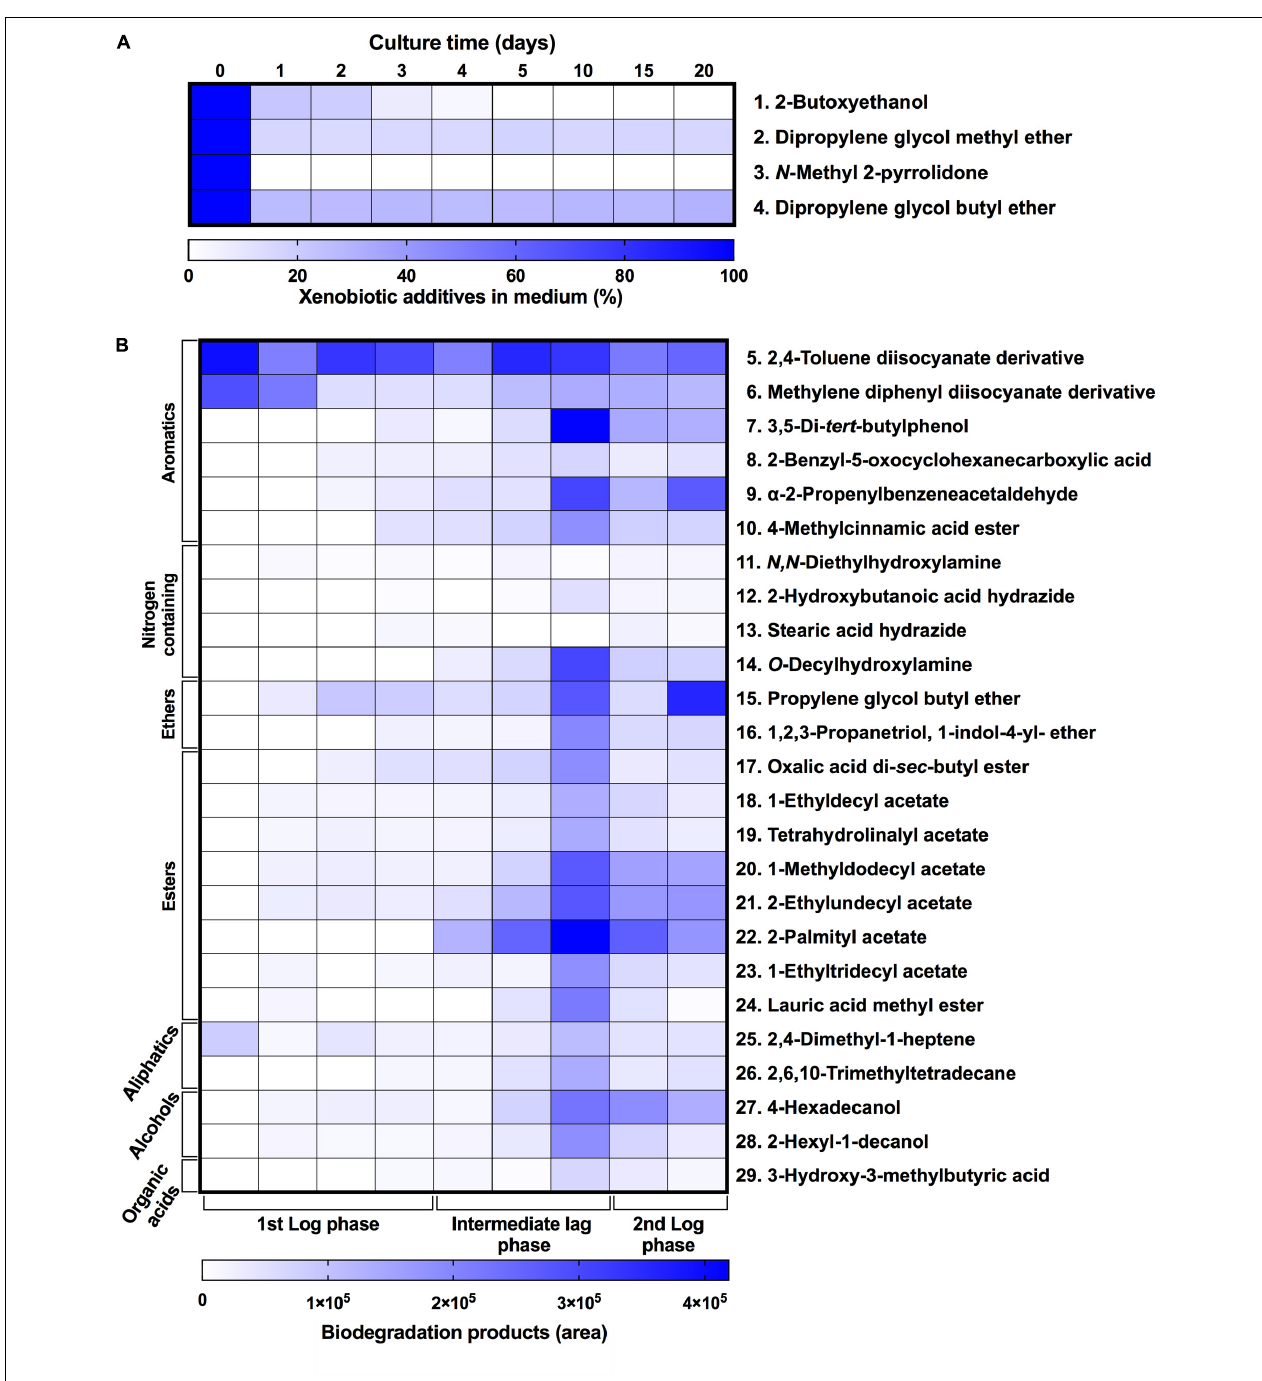
FIGURE 2 | Xenobiotic additives consumed (A) and PE-PU-A biodegradation products generated (B) by the BP8 community. Cell-free supernatants were extracted at different cultivation times with chloroform:methanol and analyzed by GC-MS. (A) Additives were quantified using standard curves for each compound and (B) biodegradation products by analyzing their areas in independent chromatograms. n = 3. Compounds with mass spectra similarity values over 700 were considered the same compounds of the Library hits. The numbers in the compounds correspond to signals in the chromatograms of Supplementary Figure S1 .